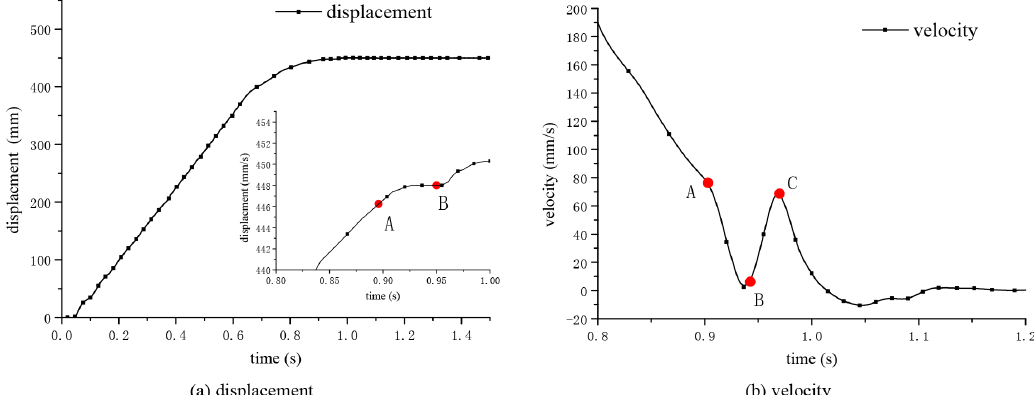
Figure 3. Test of the 0–450mm positioning.